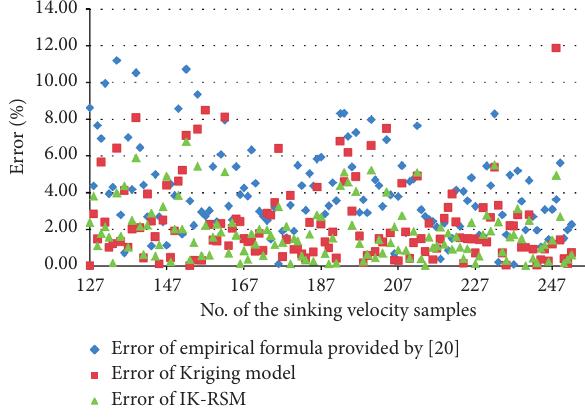
Figure 5: Error comparison of the various models for the sinking